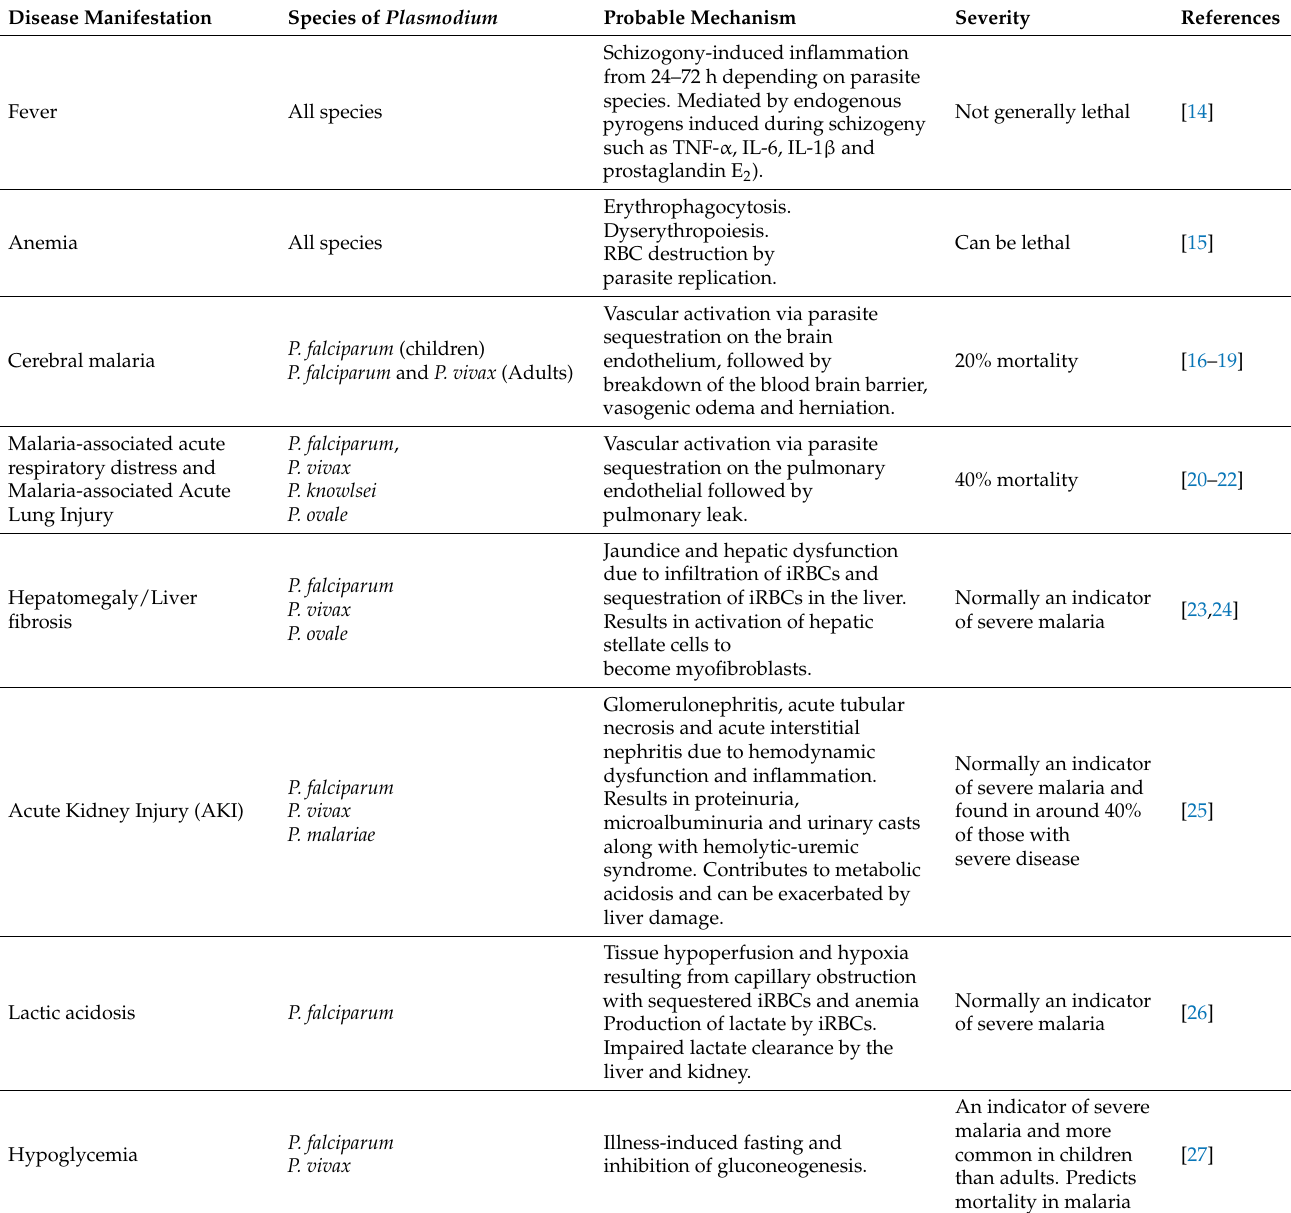
Table 1. The main clinical manifestations of Plasmodium